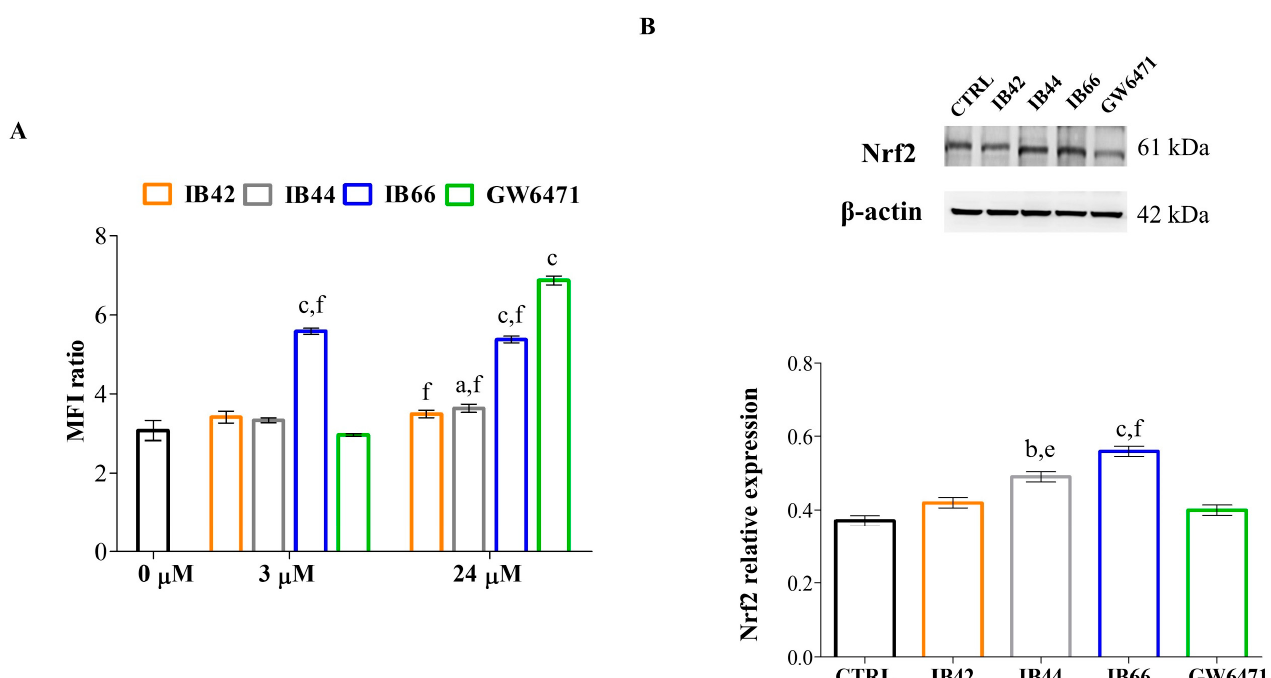
Figure 6. Generation of superoxide anions and Nrf2 expression levels. ( A ) The bar graph shows mean fluorescence intensity (MFI) ratios related to the emission in the FL-2 channel which are proportional to the generation of superoxide anions. Values are the mean ratios ± S.D. (n = 6) of the MFI generated from each sample on the unstained control (negative). 0 µ M = untreated control. ( B ) Western blot analysis of Nrf2 in the presence of compounds at 3 µ M for 24 h. β -actin is used as loading control. The bar graph shows densitometric values related to Nrf2 expressed as mean densitometric measurements ± S.D. (n = 3) normalized on the ones of the loading control. CTRL = untreated control. a ( p < 0.01), b ( p < 0.001), and c ( p < 0.0001) between untreated cultures and treated samples. e ( p < 0.001) and f ( p < 0.0001) between GW6471-treated cultures and samples in the presence of phenylsulfonimide